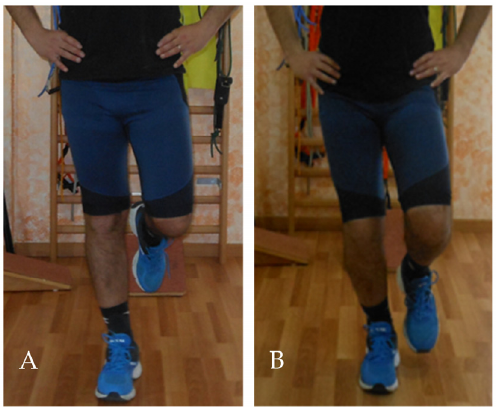
Figure 1. Single leg squat test, initial test position ( A ), and final test position ( B ).